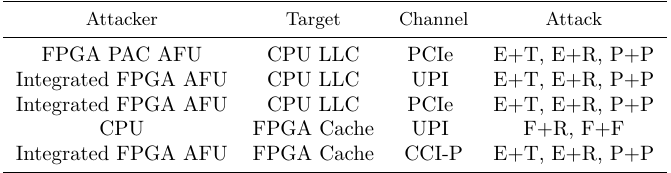
Table 3: Summary of our cache attacks analysis: OPAE accelerates eviction set construction by making huge pages and physical addresses available to